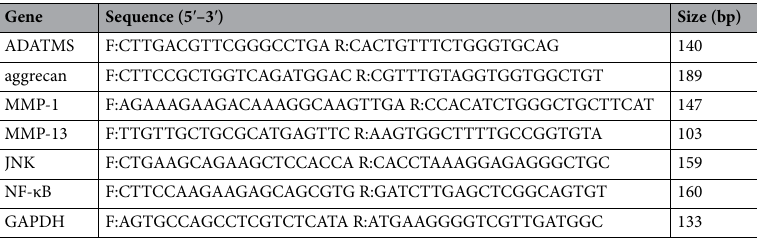
Table 1. Primer sequences used for